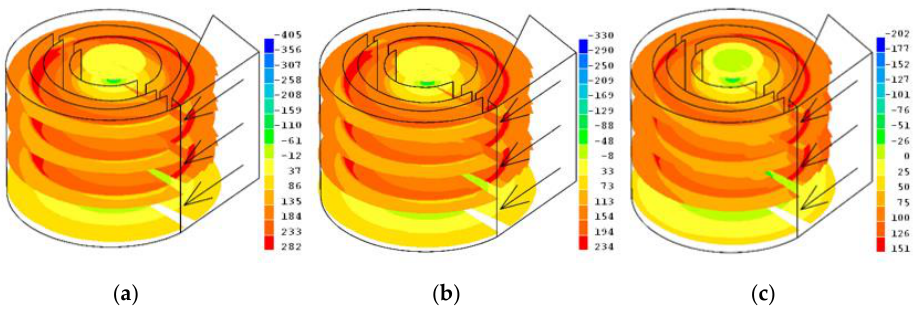
Figure 6. Air flow pressure distribution in the six-channel cyclone structure using the median-diameter (8.995 μm) glass particulate matter at 9.3 m/s ( a ), 8.3 m/s ( b ), and 6.3 m/s ( c ) cyclone inlet velocities.